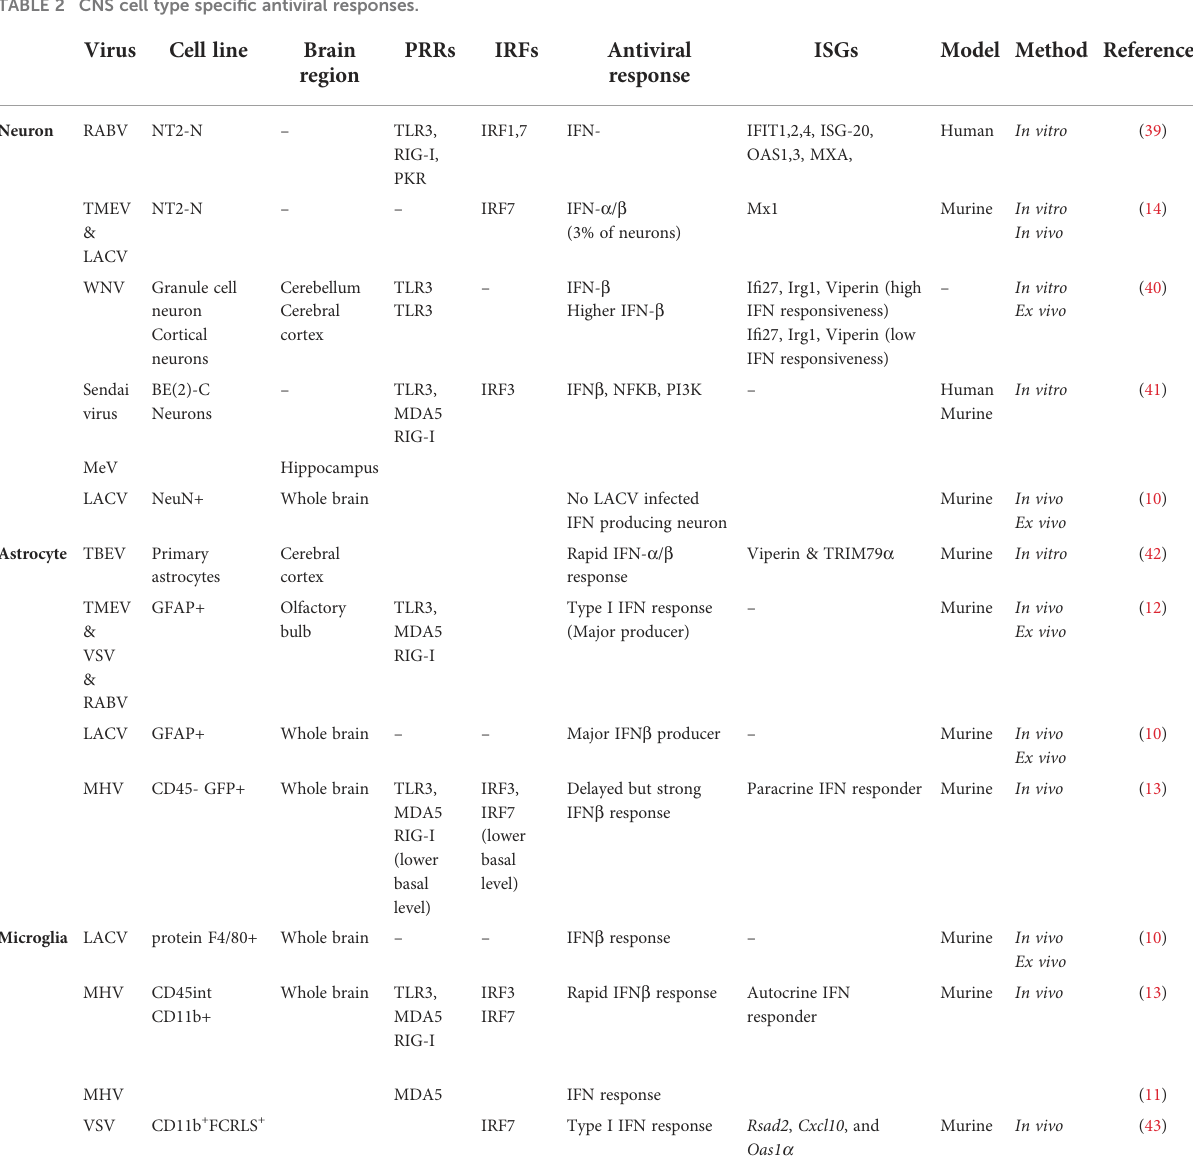
TABLE 2 CNS cell type speci fi c antiviral